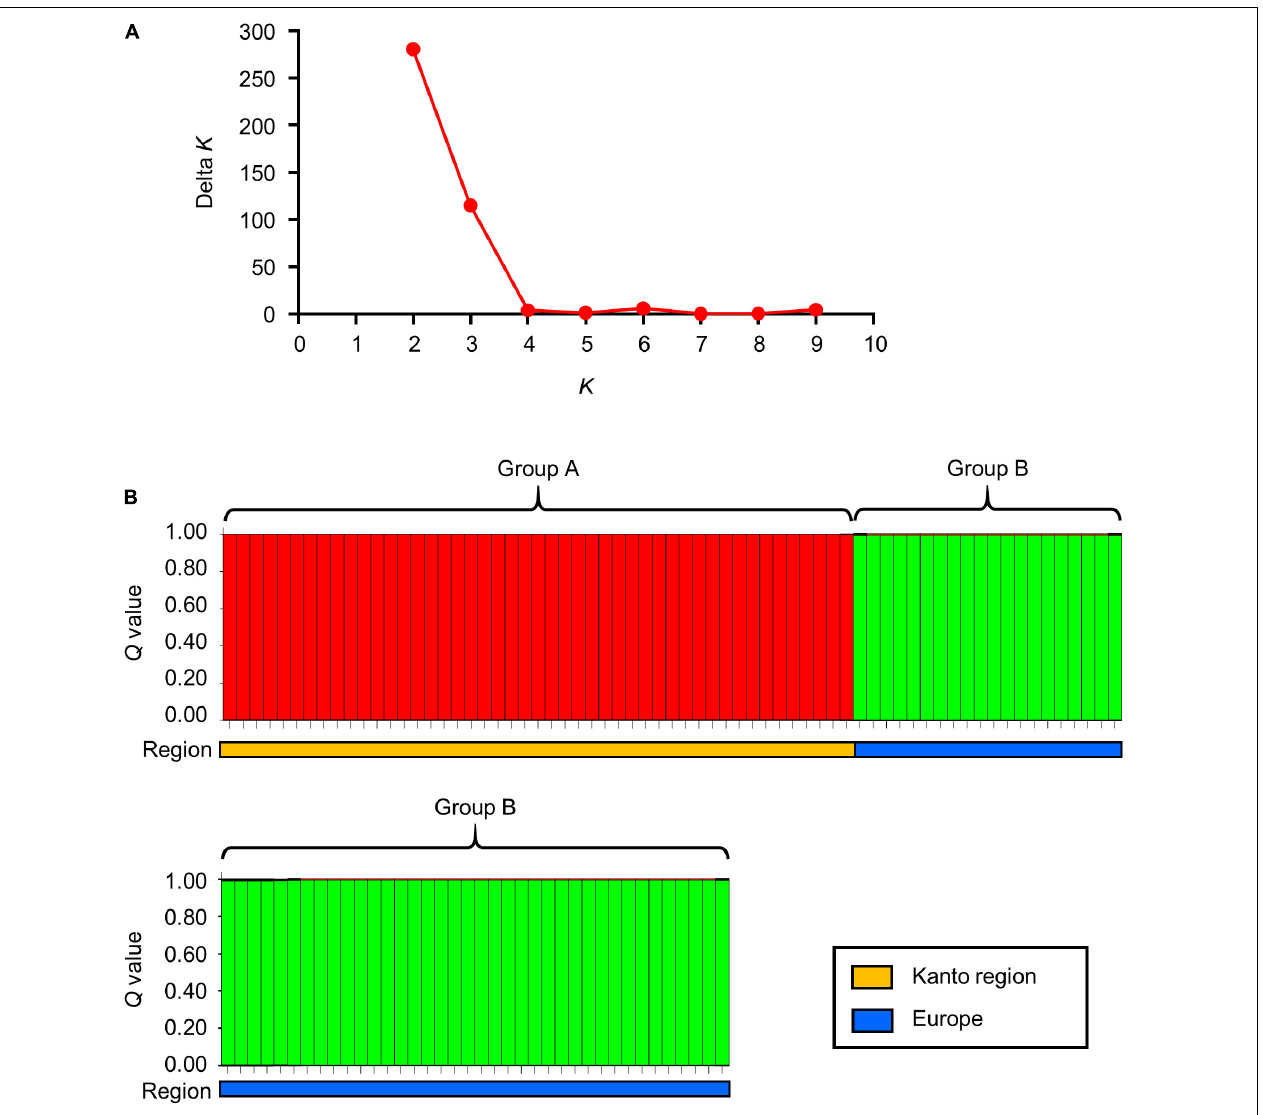
FIGURE 2 | Bayesian cluster analysis of S . Chester isolated in the Kanto region of Japan and Europe. (A) This graph represents Delta K (Y-axis) against the assumed sub-populations (X-axis). (B) This panel shows the genetic structure of the 105 S . Chester isolates from the Kanto region and from Europe under the assumption of K = 2. (B) This panel contains 105 red and light green squares, and the height of each square indicates the posterior probability value ( Q ) of the isolate. These red and light green squares represent groups A and B, respectively. The orange and blue bars below the 105 squares indicate the region where each isolate originated (i.e., the Kanto region or Europe). The details of this analysis are described in Supplementary Table 1 .